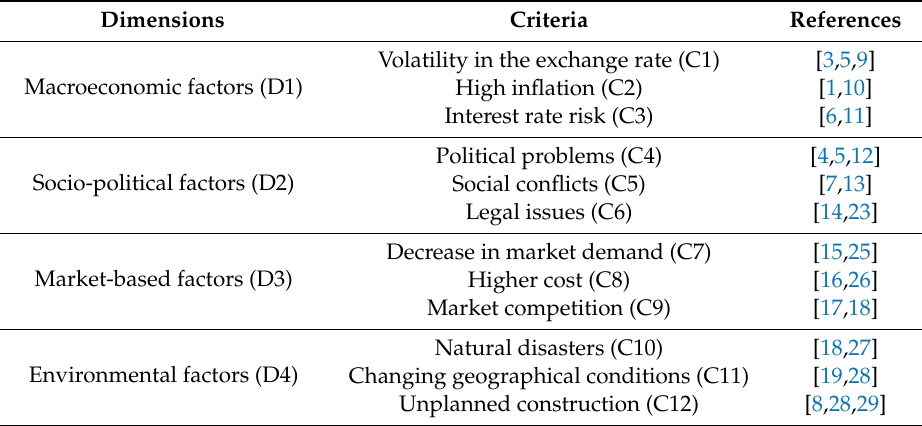
Table 2. List of the systematic risk factors for wind energy